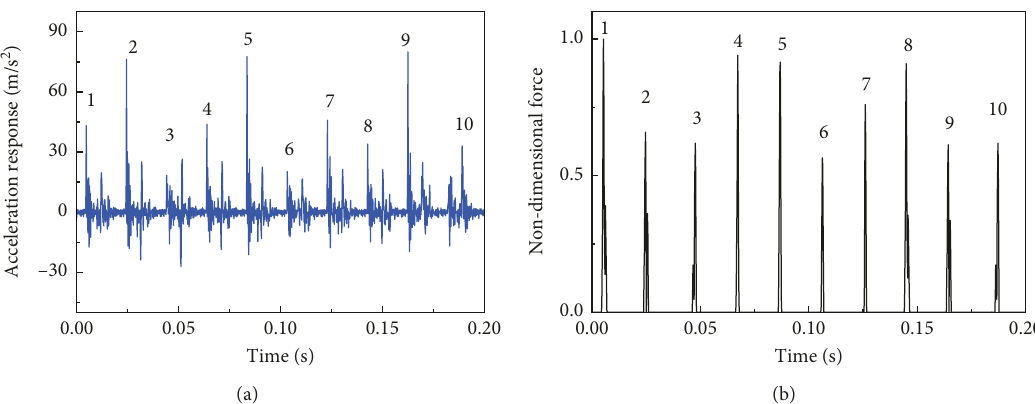
Figure 14: Acceleration response and nondimensional force on rubbing ring under heavy rub-impact condition. (a) Experimental ac- celeration response. (b) Numerical nondimensional